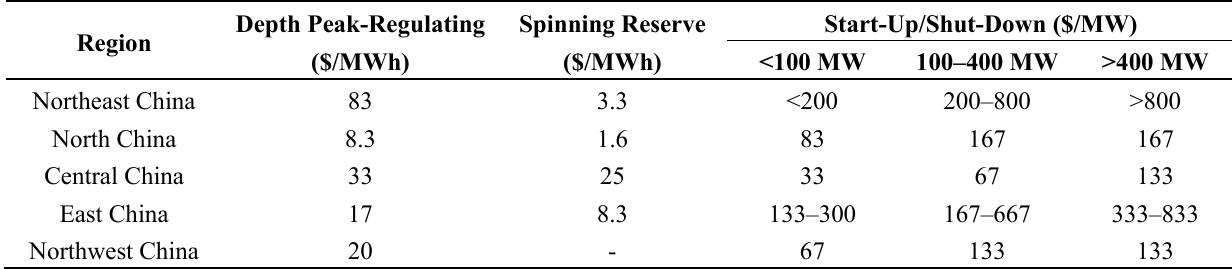
Table 2. Compensation standard for AS in different regions of